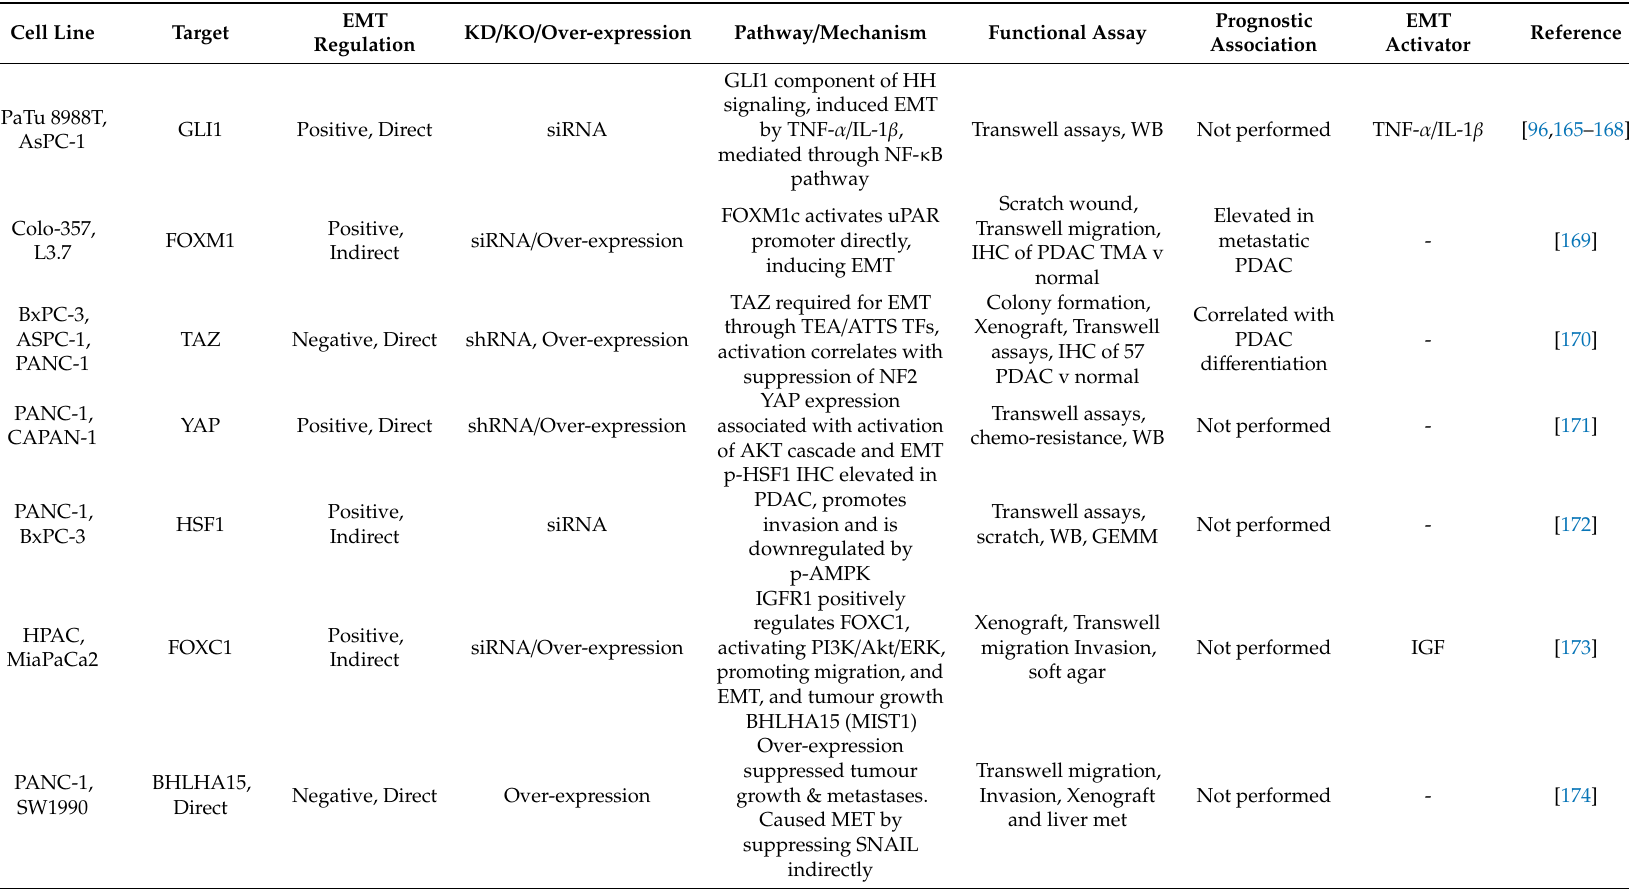
Table 7. Transcription Factors and Cofactors. This table describes transcription factors and cofactors that influence gene expression required for actions of EMP in their respective systems. Candidates that exhibit clinical correlation with lymph node metastasis are shown in